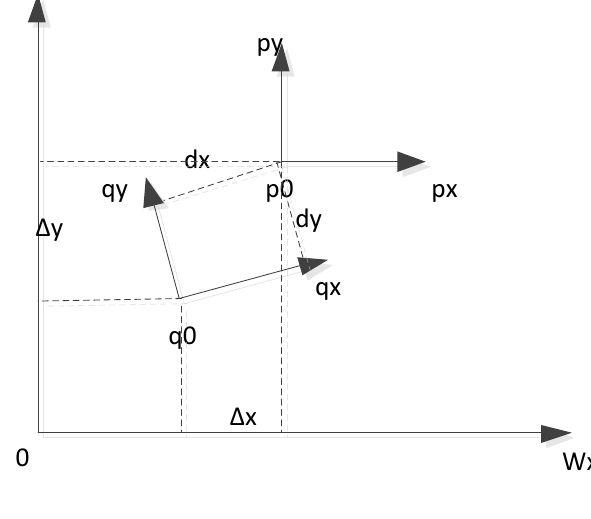
Figure 3. Coordinate reference relationship of